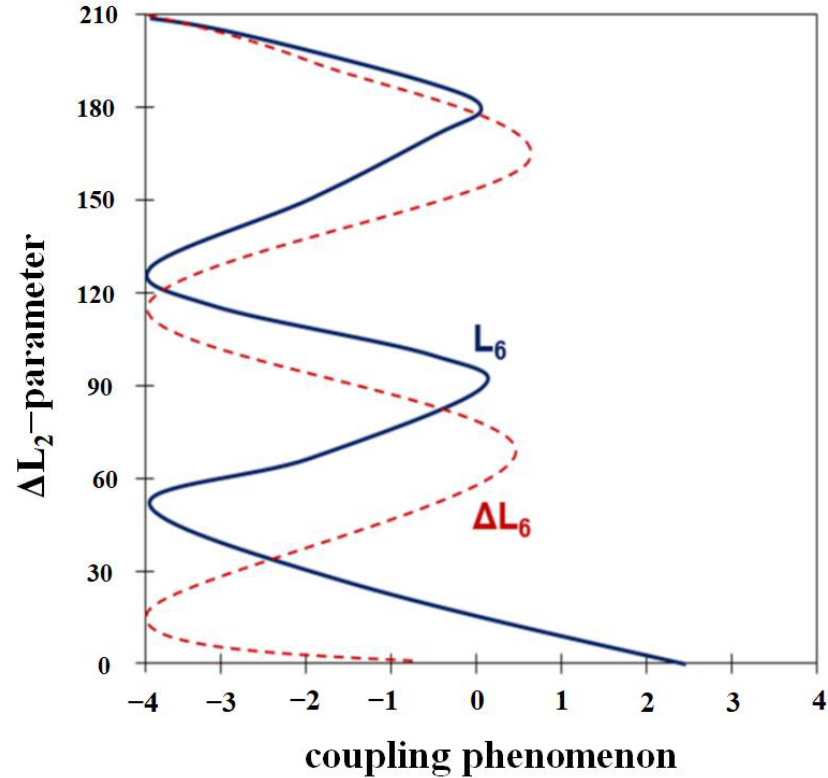
Figure 9. Coupling phenomenon corresponding to the variation of wire length ( ∆ L 2 ) of the designed manipulator.